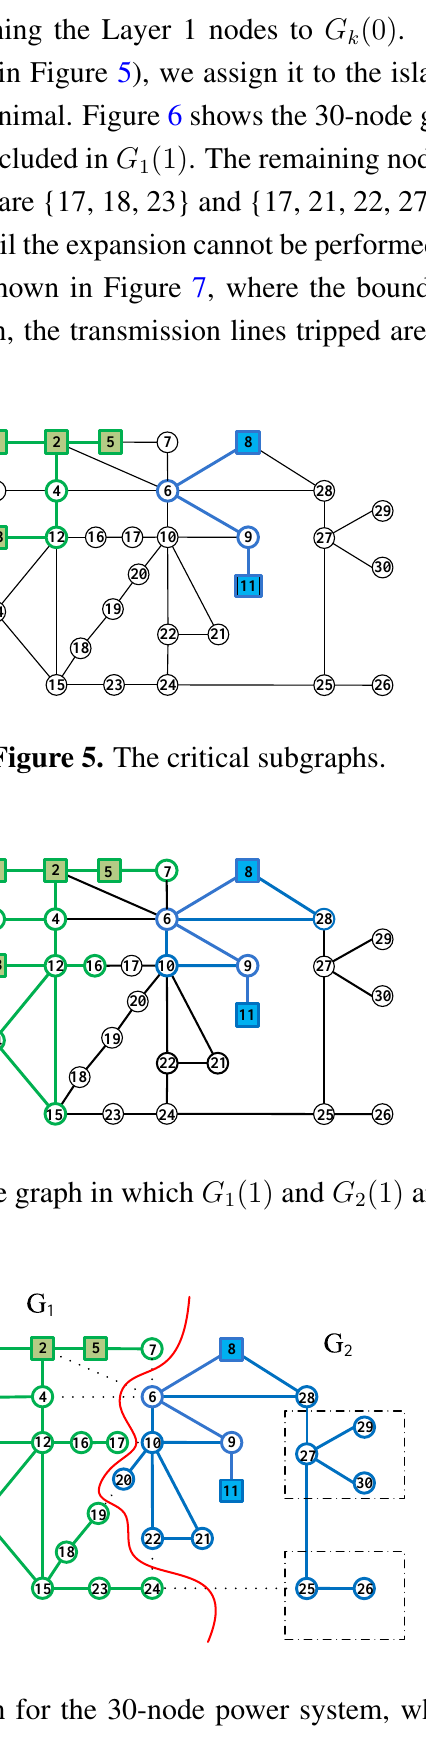
Figure 7. The initial solution for the 30-node power system, where the dotted lines have been